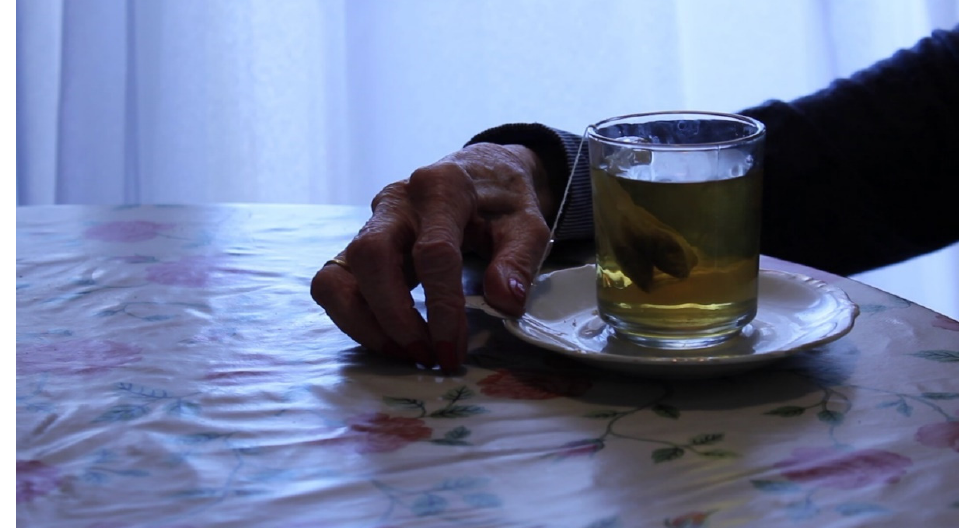
Figure 1. Dvora Morag, “And you shall tell your daughter”, 2014. Single-channel